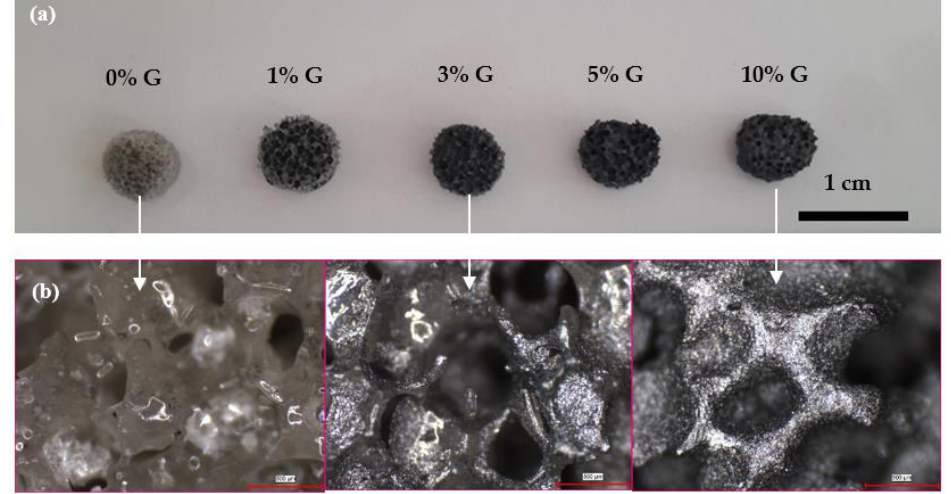
Figure 2. ( a ) Digital and ( b ) optical microscope images of the bioactive glass-based composite scaffolds (PCL-coated, containing 0, 1, 3, 5 and 10 wt% graphene) fabricated in the study, scale bar: 500 µm for optical microscope images.